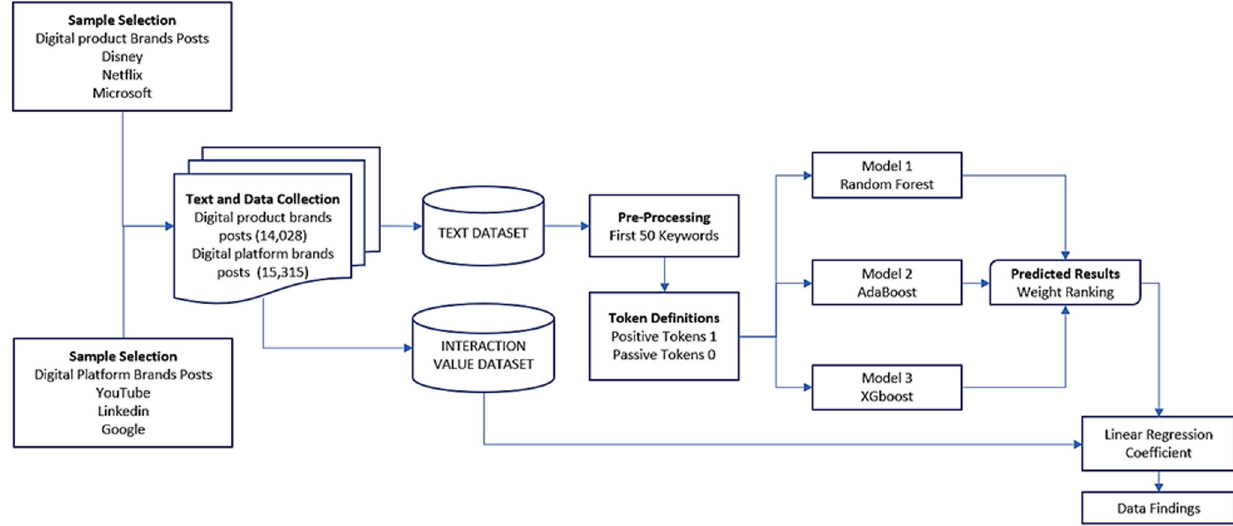
Fig. 1 Data analysis fl ow chart, this study was conducted in the process and proposed a framework to strengthen social media monitoring and data